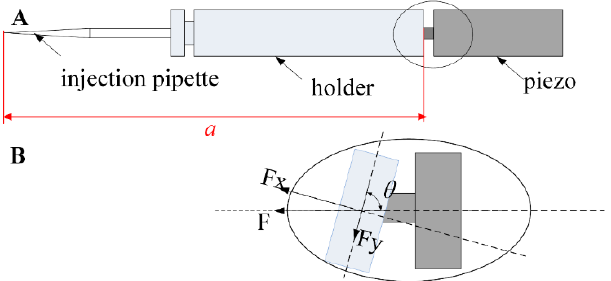
Figure 2. ( A ) Structure of the conventional injector. ( B ) Partial enlarged detail of the junction where the front of the piezoelectric actuator is connected to the holders in the conventional injector and a slight deviation θ is generated from installation errors.